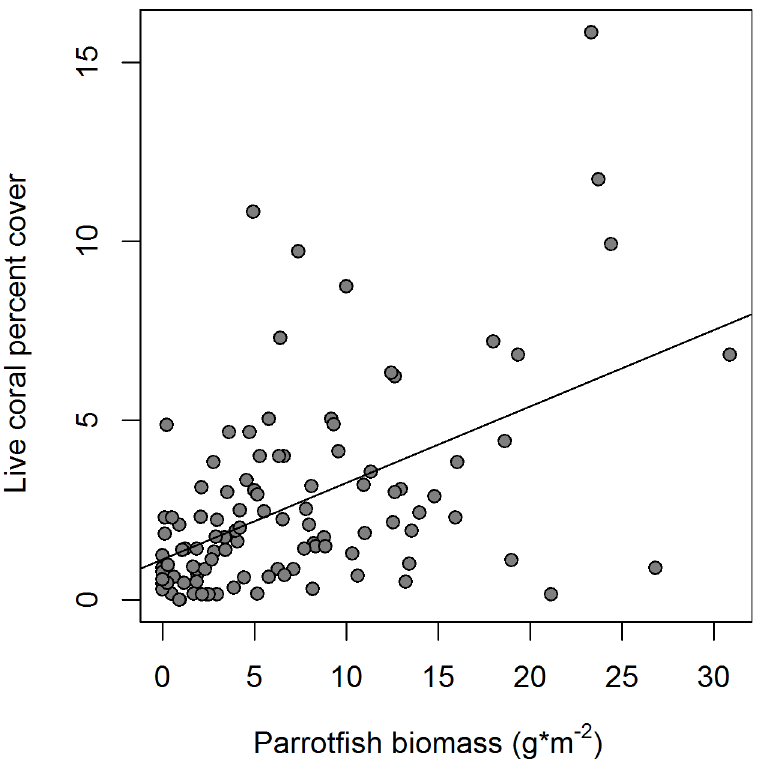
Fig 7. Scatterplot of percent live coral and parrotfish biomass. Data are from 108 sites aroundBarbuda (r 2 = 0.25, p < 0.001).